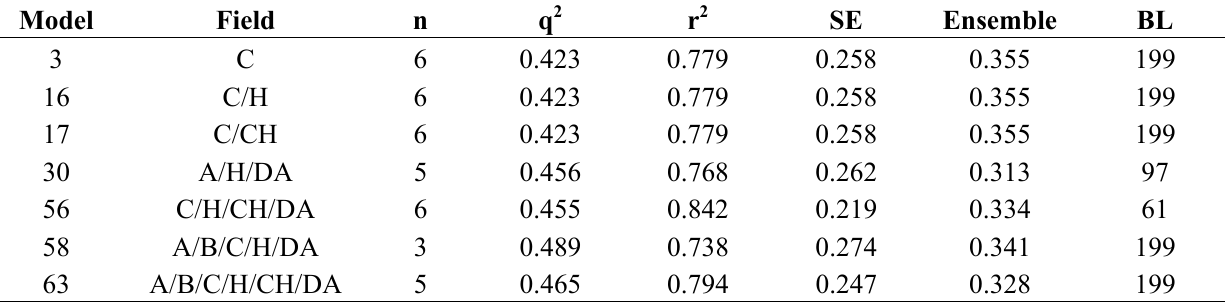
Table 3. Regression summary of HQSAR models combined with various fragment distinction parameters for the 64 Ts as inhibitors of [ 3 H]ketanserin binding. a